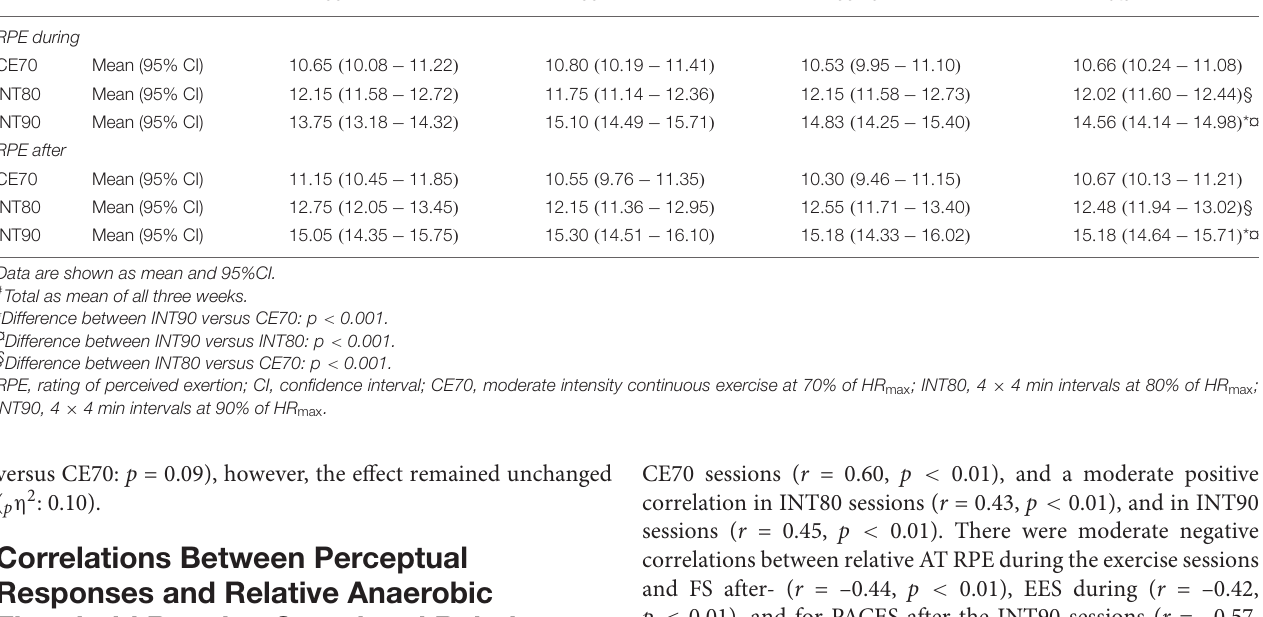
TABLE 4 | Rating of Perceived Exertion during- and after the exercise sessions. Week 1 Week 2 Week